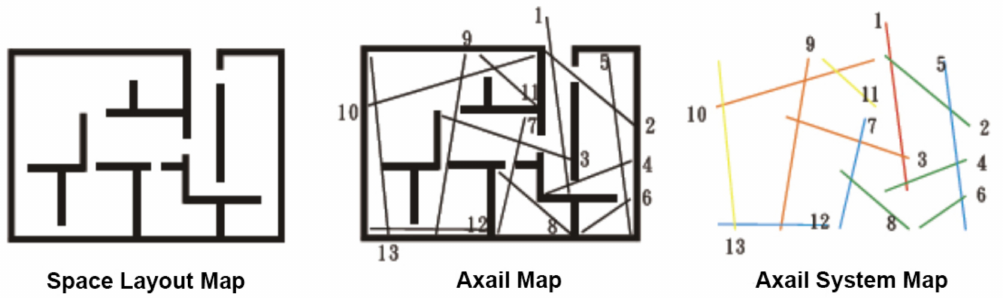
Figure 2. Analysis of the axial map